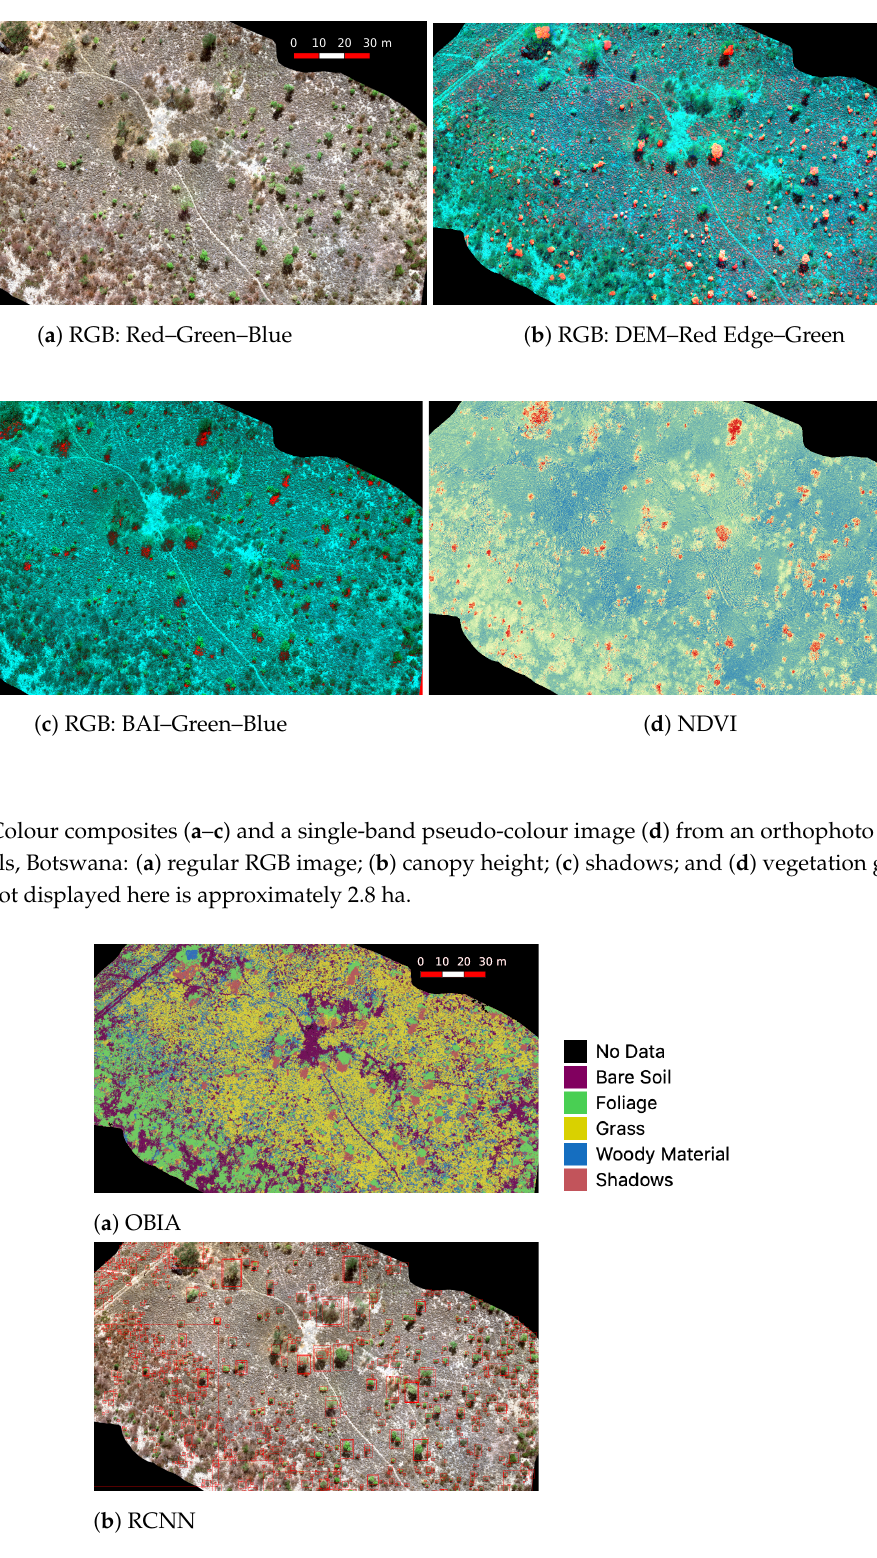
Figure 7. Example classification done using OBIA, where ( a ) shows the classification and ( b ) tree-like objects detected by the Mask R-CNN